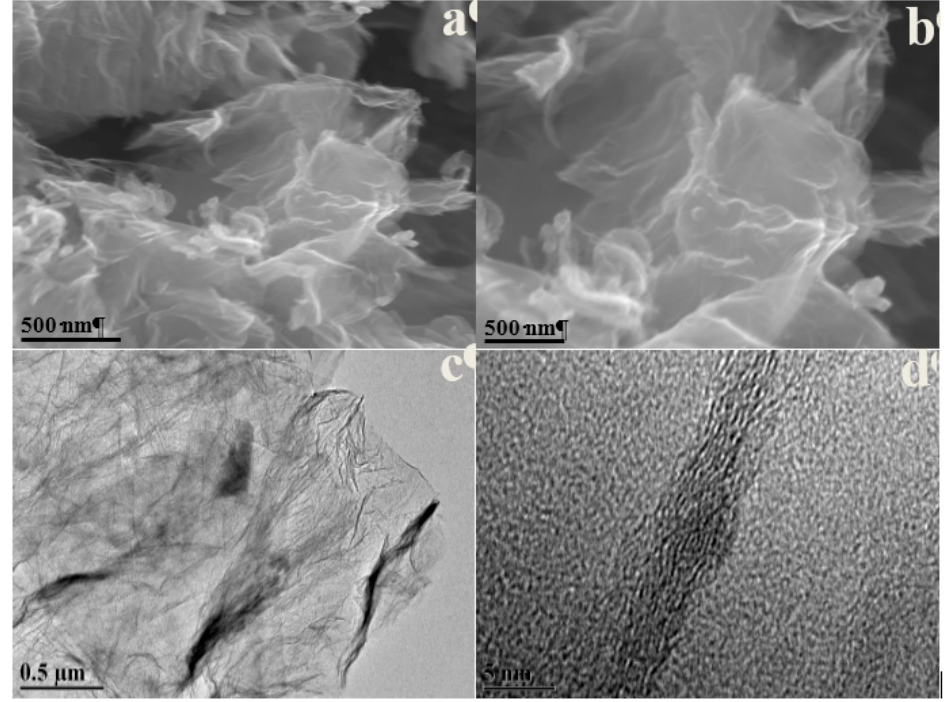
Figure 1. Scanning electron microscopy (SEM) images ( a , b ) and transmission electron microscopy (TEM) images ( c , d ) of P, N dual doped reduced graphene oxide (PN-rGO).